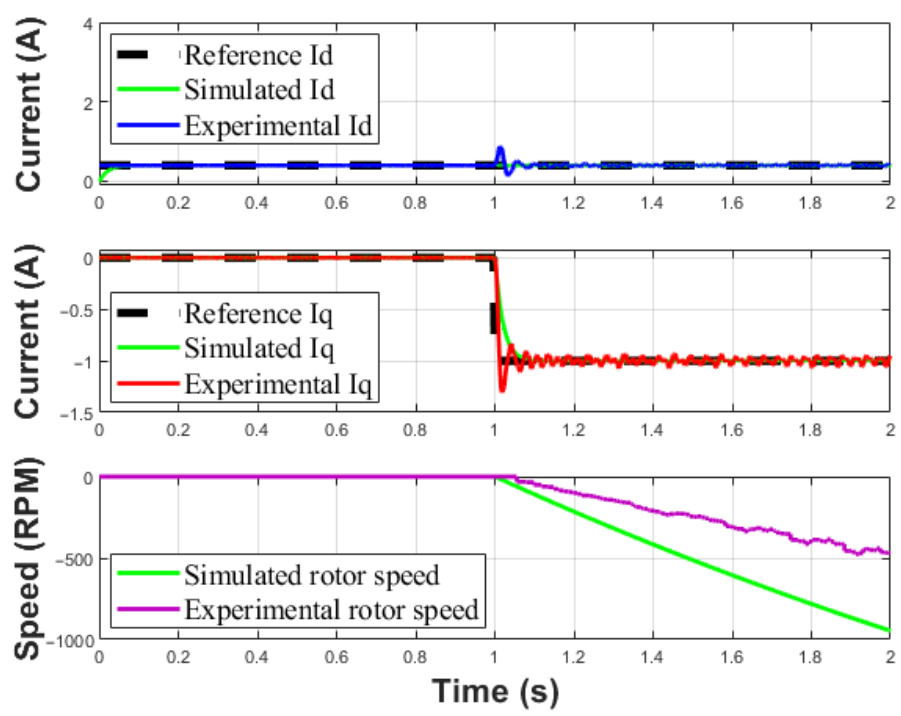
Figure 20. Current control loop behavior i ∗ q = − 1.0